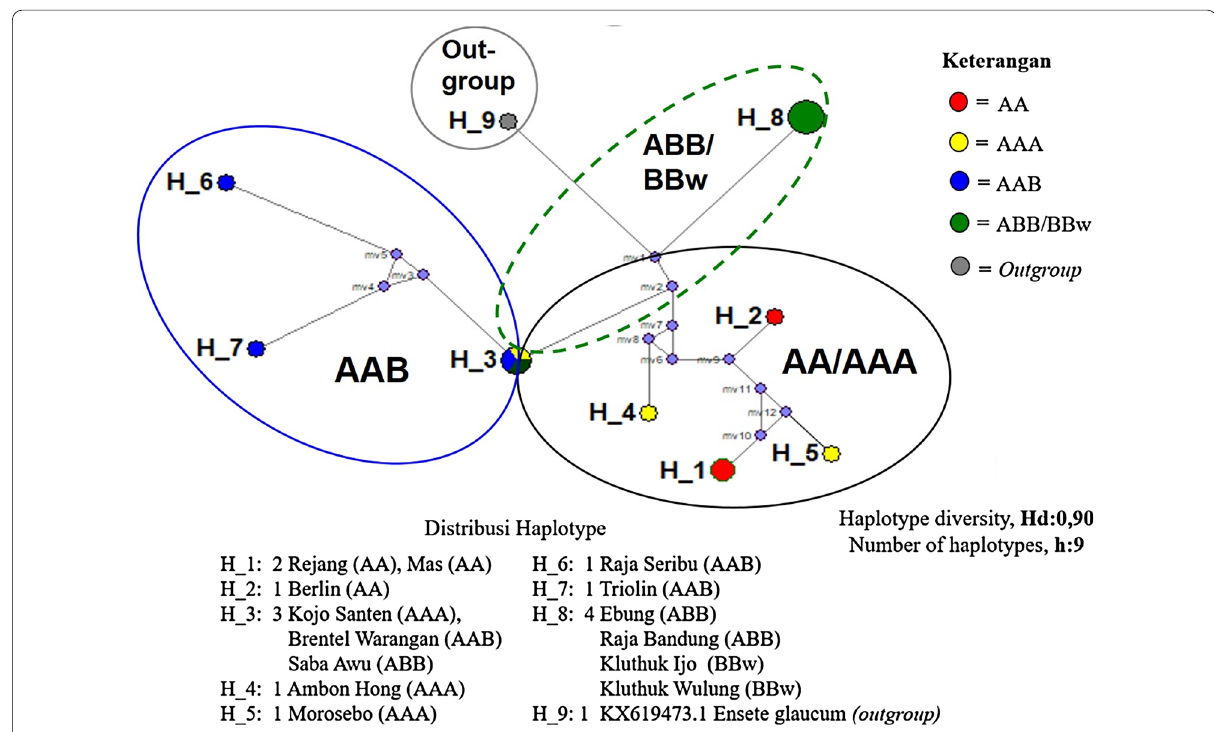
Fig. 3 Haplotype network of 14 banana cultivars from Java based on the mat K